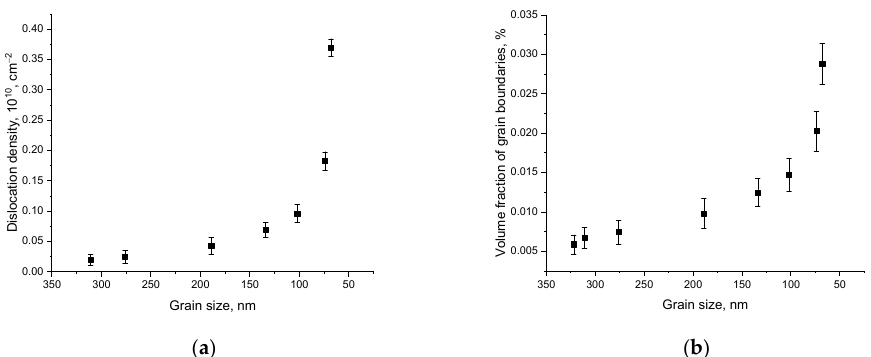
Figure 4. ( a ) Results of dislocation density change depending on grain size; ( b ) Evaluation results of the volume fraction contribution of grain boundaries in ceramics. As can be seen from the data presented, the change in the dislocation density is most crease in grains and an increase in their homogeneity are observed. Moreover, these